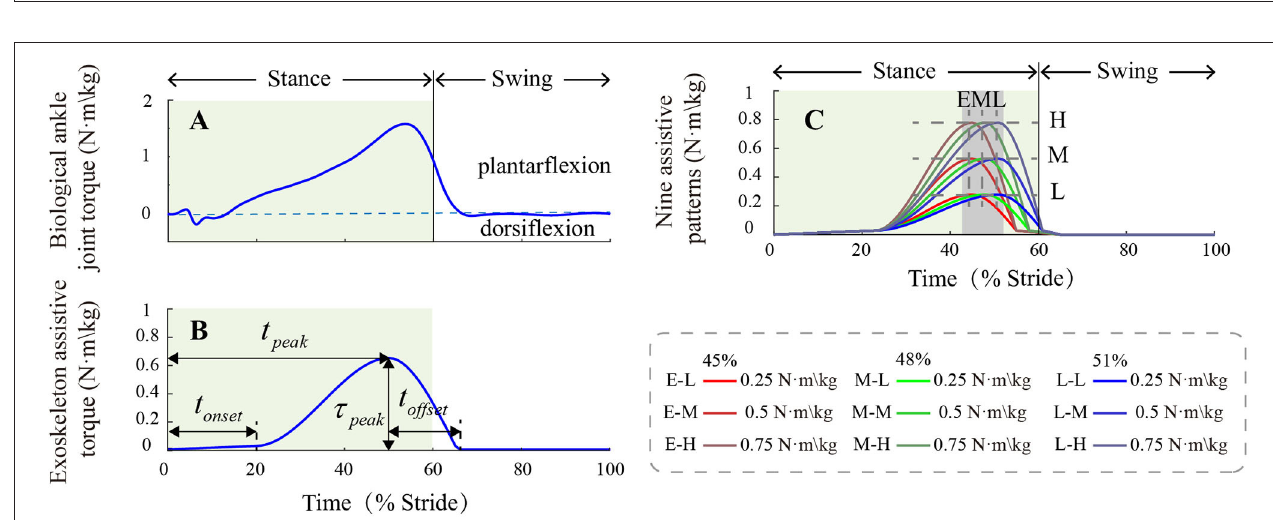
FIGURE 2 | (A) Biological ankle moment during human level walking. (B) The ankle exoskeleton plantarflexion assistive torque profile and four assistance parameters: onset timing, peak torque timing, peak torque magnitude, and offset timing. (C) Nine assistance patterns that applied in the experiment. The light green rectangle shows the stance phase in a gait cycle.